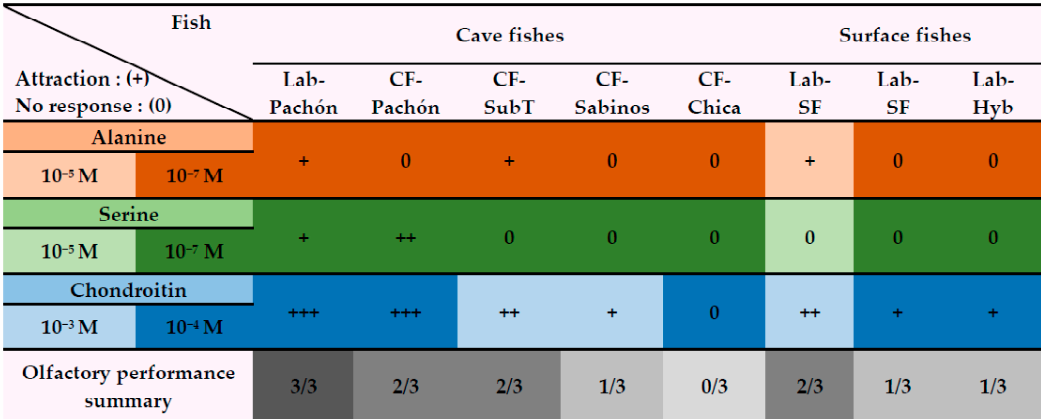
Table 1. A summary of the results obtained in all the cave and laboratory olfaction experiments. Attractive response ( + ) or no response (0) is summarized for each cavefish or surface fish population, when recorded in the field or in the lab (as indicated in the di ff erent columns) for the 3 di ff erent odors studied (as indicated in the di ff erent rows; orange / alanine, green / serine, blue / chondroitin). Light and dark colors indicate response to the high concentration (light color, lower detection capacities) or the low concentration (dark color, better detection capacities) of the odor considered. The last line (grey shades) indicates to how many odors, out of the 3 tested, the fish have